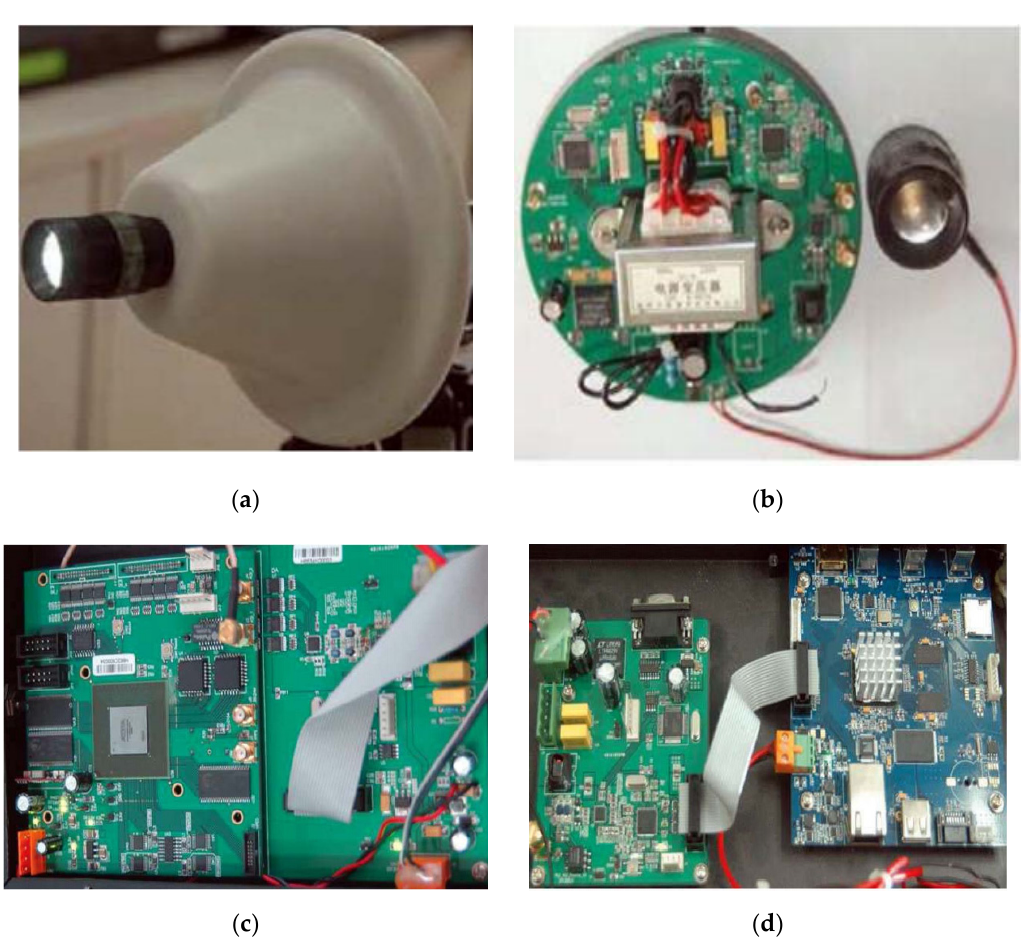
Figure 13. The hardware devices of PLC and IWOC broadcasting system in the laboratorial environment: ( a ) LED temp [15]; ( b ) PLC to IWOC module [15]; ( c ) PLC modulator [15]; ( d ) Demodulator [15].